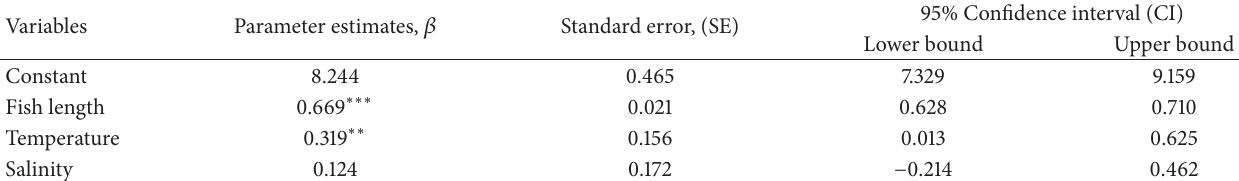
Table 6: Fitted values of the predictor variables via multiple regression analysis.